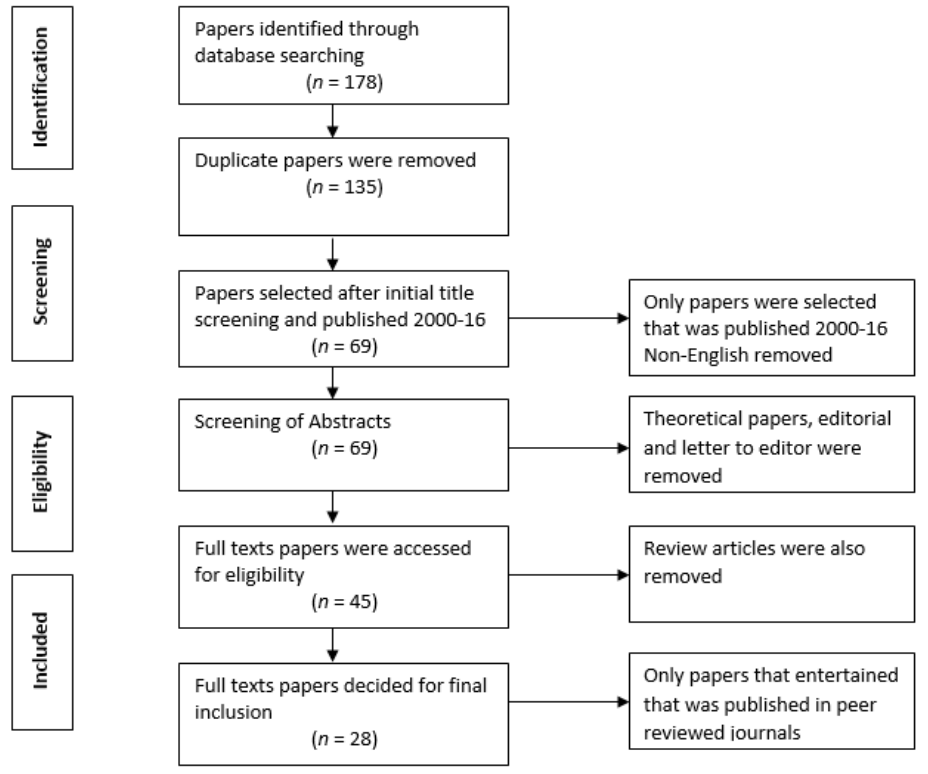
Figure 1. The process of selection of relevant papers is given criteria.